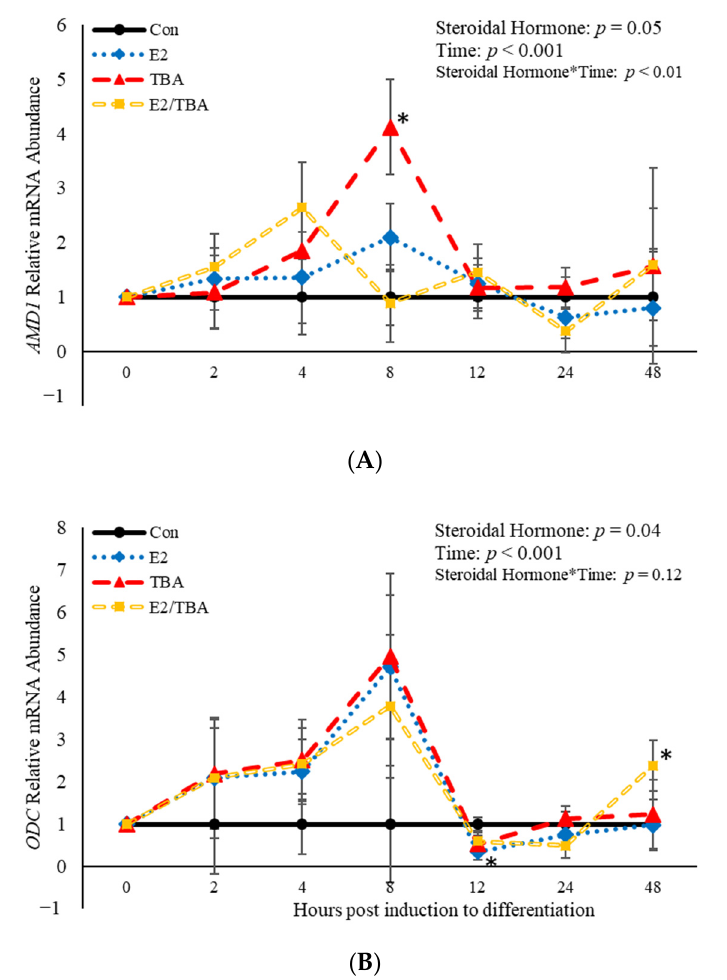
Figure 3. Relative mRNA abundance of S-adenosylmethionine decarboxylase ( AMD1; ( A ) and ornithine decarboxylase (ODC; ( B ) from primary bovine satellite cells cultures following treatment with 10 nM trenbolone acetate (TBA), 10 nM estradiol (E2), or 10 nM E2 and 10 nM TBA (E2/TBA). Cultures were grown to 80% confluency and treated with DMEM/3% horse serum and 10 nM TBA, 10 nM E2, or 10 nM E2/TBA. Abundance was measured 0, 2, 4, 8, 12, 24 and 48 h after treatment, as described in the Materials and Methods. The main effects of steroidal hormone, time and steroidal hormone *time in mRNA abundance were analyzed as repeated-measures. Data represent relative mRNA abundance normalized against 18S abundance and are presented as LS mean ± SEM from six separate replicates utilizing BSCs isolated BSCs isolated from at least three different animals. Differences ( p < 0.05) between steroidal hormones found in anabolic implants and the control cultures are indicated by a * at that particular time